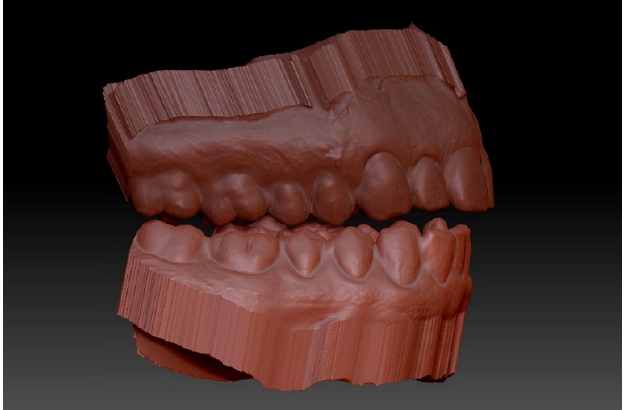
Figure 3. Virtual blocking of anatomical undercuts with the “virtual clay tool” in the Zbrush software.